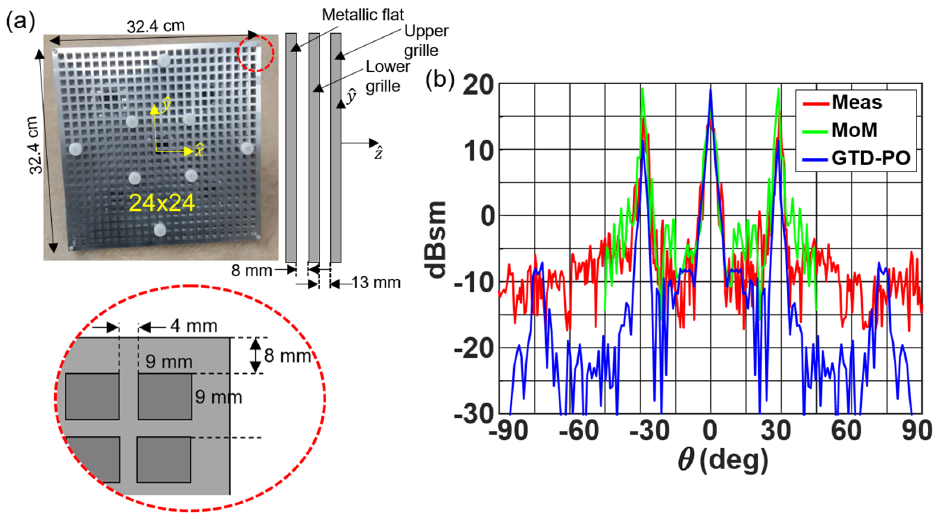
Figure 6. Double metallic grille (electromagnetic bandgap (EBG) structure). Dimensions ( a ) and monostatic RCS results ( b ) in near-field conditions (at 5.50 m): GTD–PO simulation, MoM